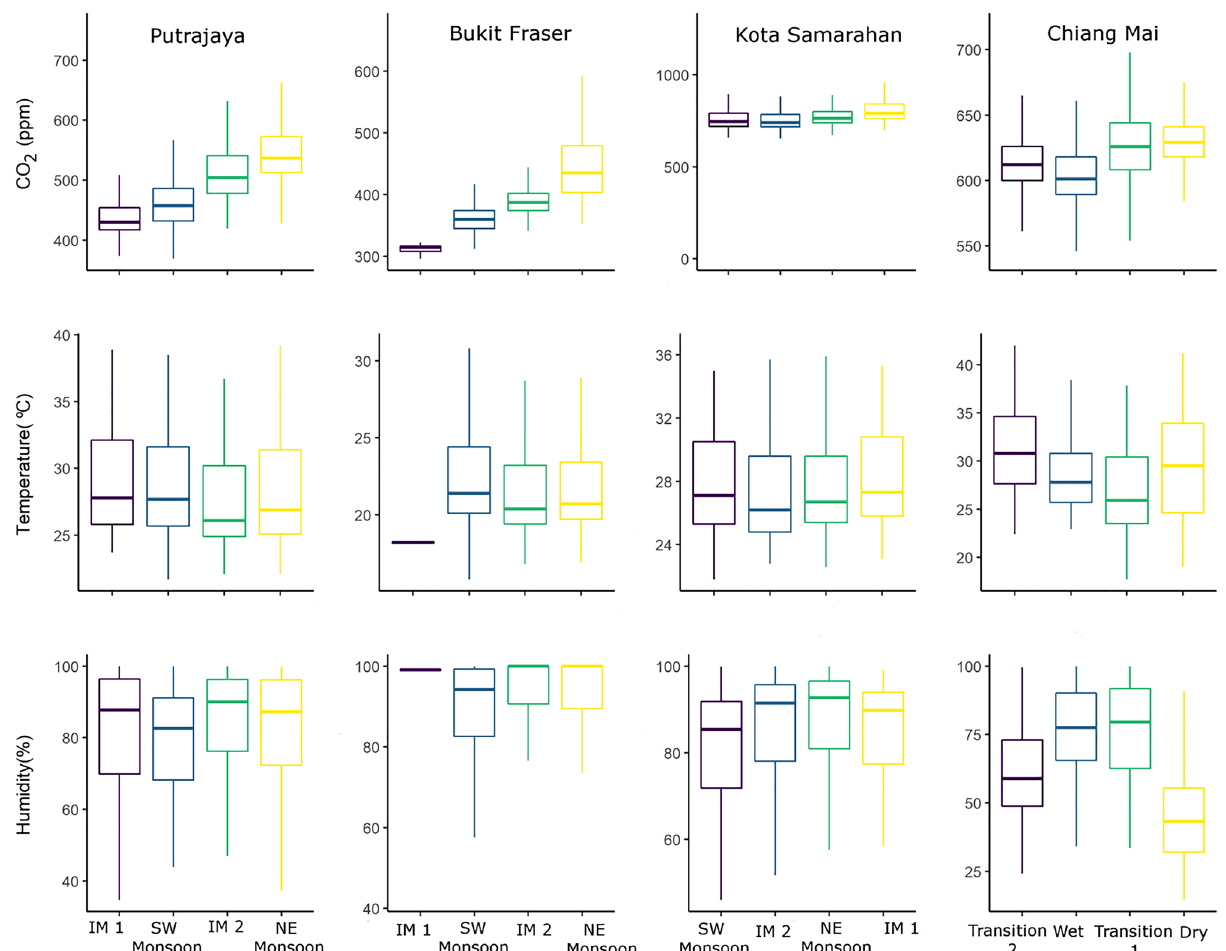
Figure 3. Seasonal variation of CO 2 , temperature and relative humidity based on different seasons in Putrajaya, Bukit Fraser, Kota Samarahan and Chiang Mai (IM 1, SW Monsoon, IM 2, and NE Monsoon represent Inter Monsoon 1, Southwest Monsoon, Inter Monsoon 2, and Northeast Monsoon